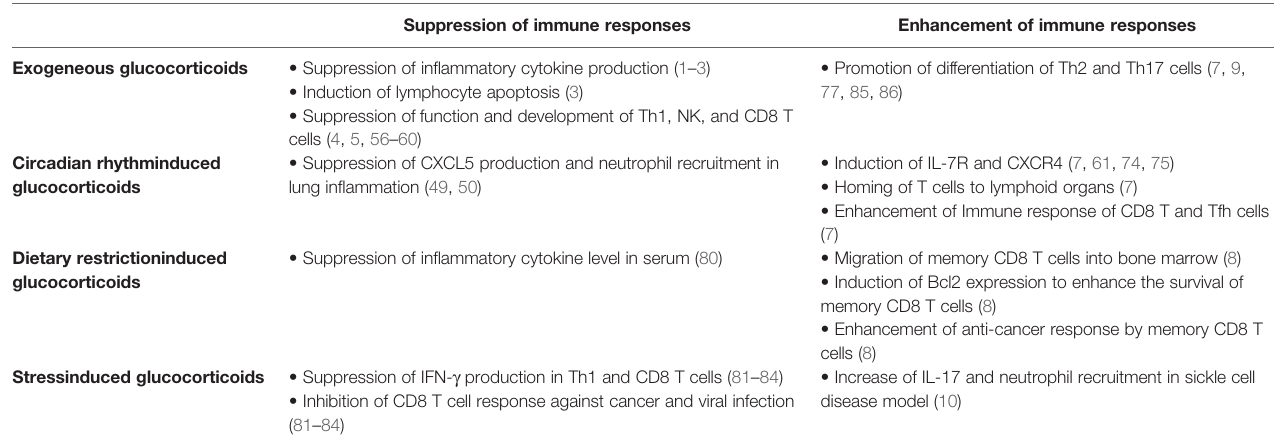
TABLE 1 | A summary of the pleiotropic effects of glucocorticoids in different conditions. Suppression of immune responses Enhancement of immune responses Exogeneous